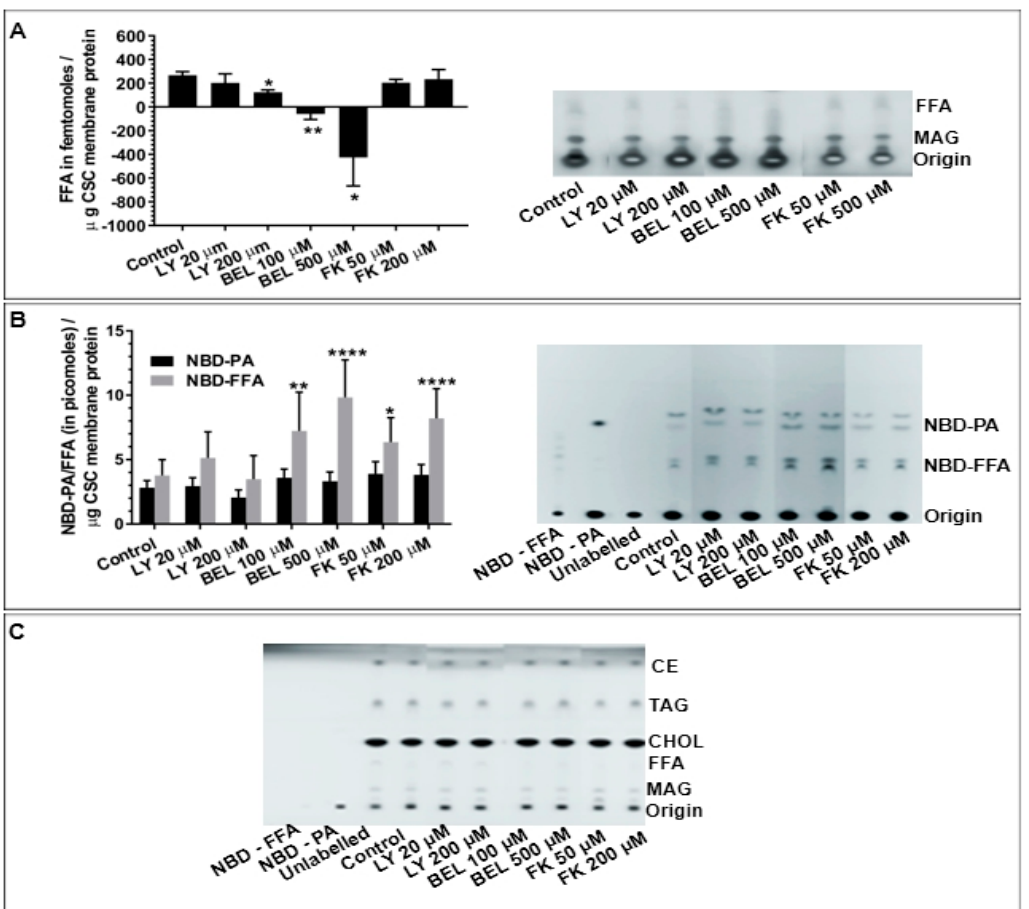
Figure 1. Detection and quantification of ( A ) endogenous CSC FFA, n = 3 separate experiments; ( B ) NBD-FFA and -PA in intact CSC after 15 min labelling with NBD-PC followed by 20 min inhibitor treatments, n = 3 separate experiments; ( C ) total CSC neutral lipids visualized on the same TLC plate as shown in B, after charring with CuSO 4 . This also confirmed consistent lipid loading in each lane. Representative chromatograms showing indicated changes in lipids. ( p -value, * < 0.05, ** < 0.005, **** < 0.0001 indicates relative di ff erence to the control). Note: A section of chromatogram is shown in A and lanes in all chromatograms are grouped together from the same HPTLC plate following removal of lanes not associated with this study. A standard neutral lipid protocol was used to resolve the lipids [56].